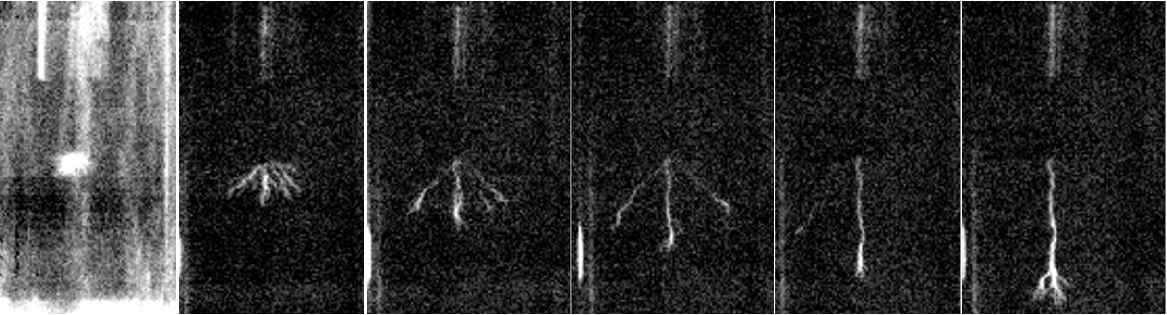
Figure A3. 0.35% DEA in cyclohexane, positive polarity, 239 kV. 5 µs between frames, Time-To- Breakdown (TTB) ≈ 40 µs.